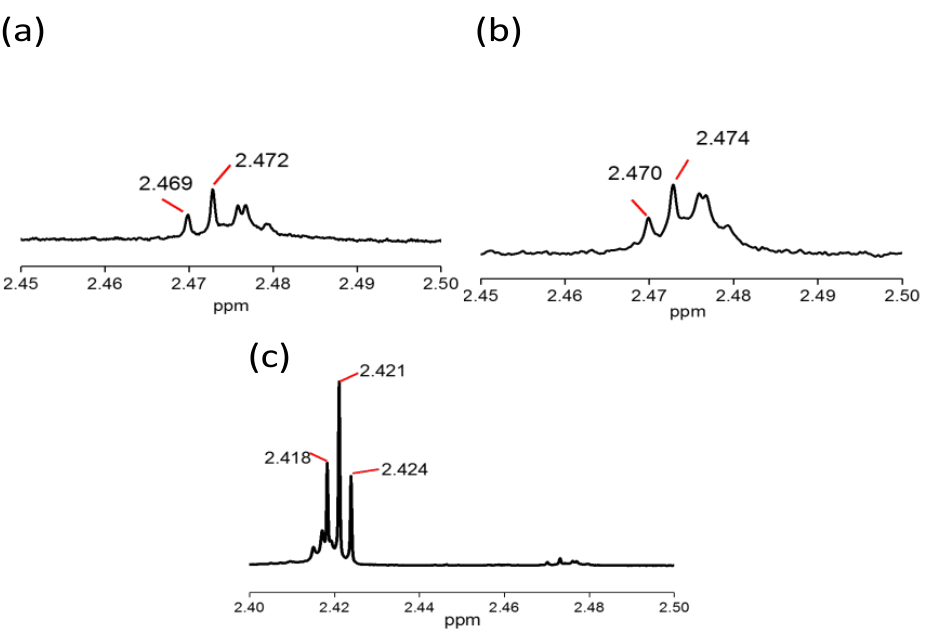
Figure 6. 1H NMR of ( a ) HNT, ( b ) CTS, and ( c )